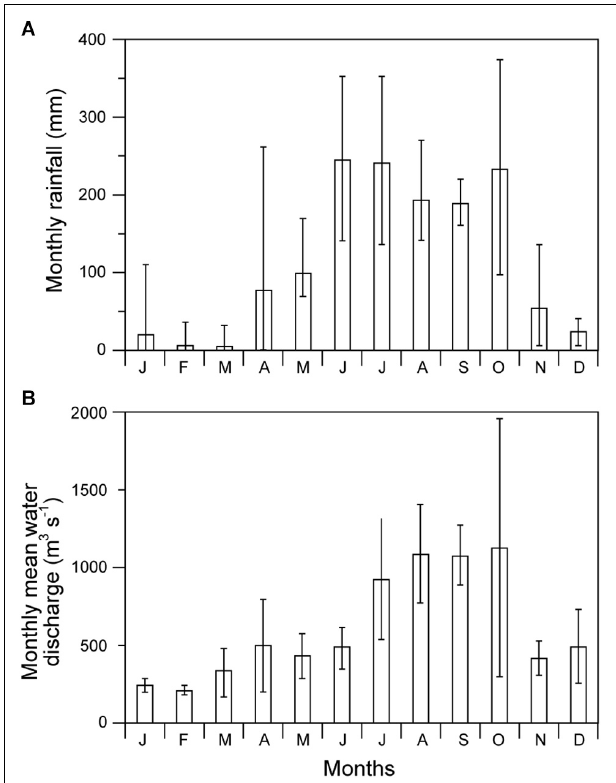
FIGURE 2 | (A) Minimum, average, and maximum monthly rainfall at V˜ung Tàu from 2012 to 2017 (from the General Statistics Office of Vietnam). (B) Minimum, average, and maximum monthly mean water discharge at Biên Hòa from 2012 to 2016 (from Nguyen et al., 2019).